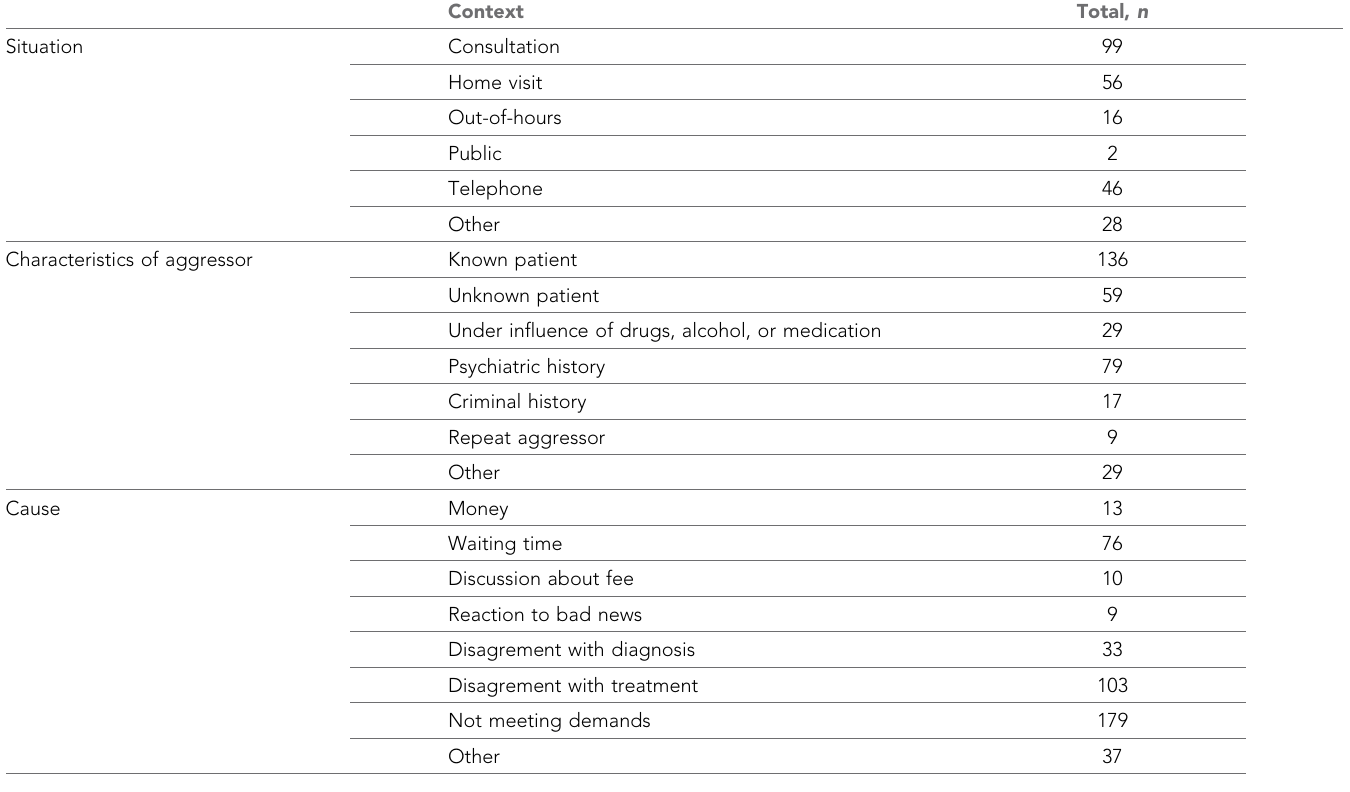
Table 4. Context of aggression incident